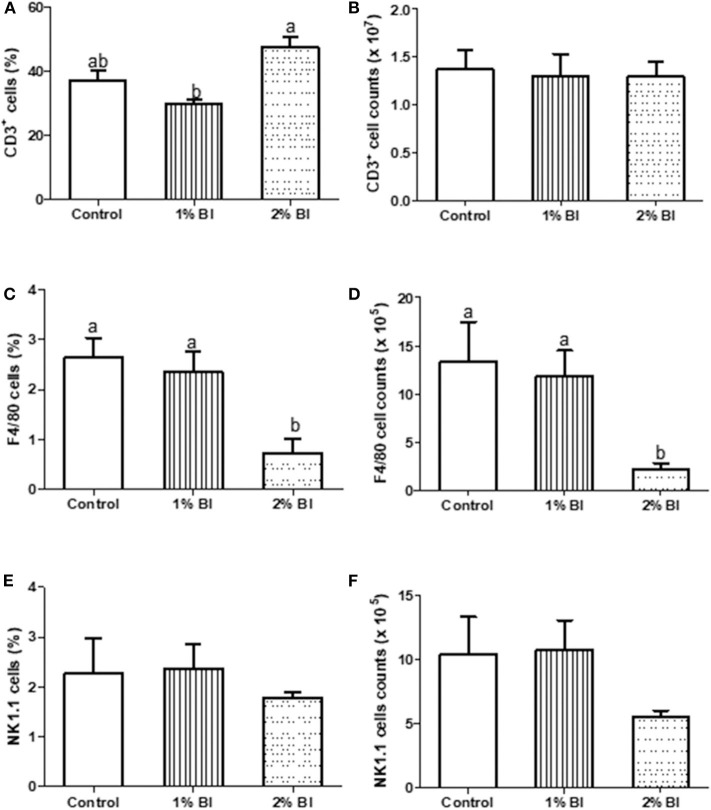
Effect of B. inquinans supplementation on splenocyte populations. On day 28, mice were sacrificed with CO2 and spleen was collected to determine the immune cell populations including T cells [CD3, (A,B)], macrophages [F4/80, (C,D)] and NK cells [NK1.1, (E,F)] by flow cytometry described as the “Materials and Methods” section. Values are means ± SEM (n = 6 mice/group). Means without a common letter differ at P < 0.05. Control, control diet; BI, B. inquinans.